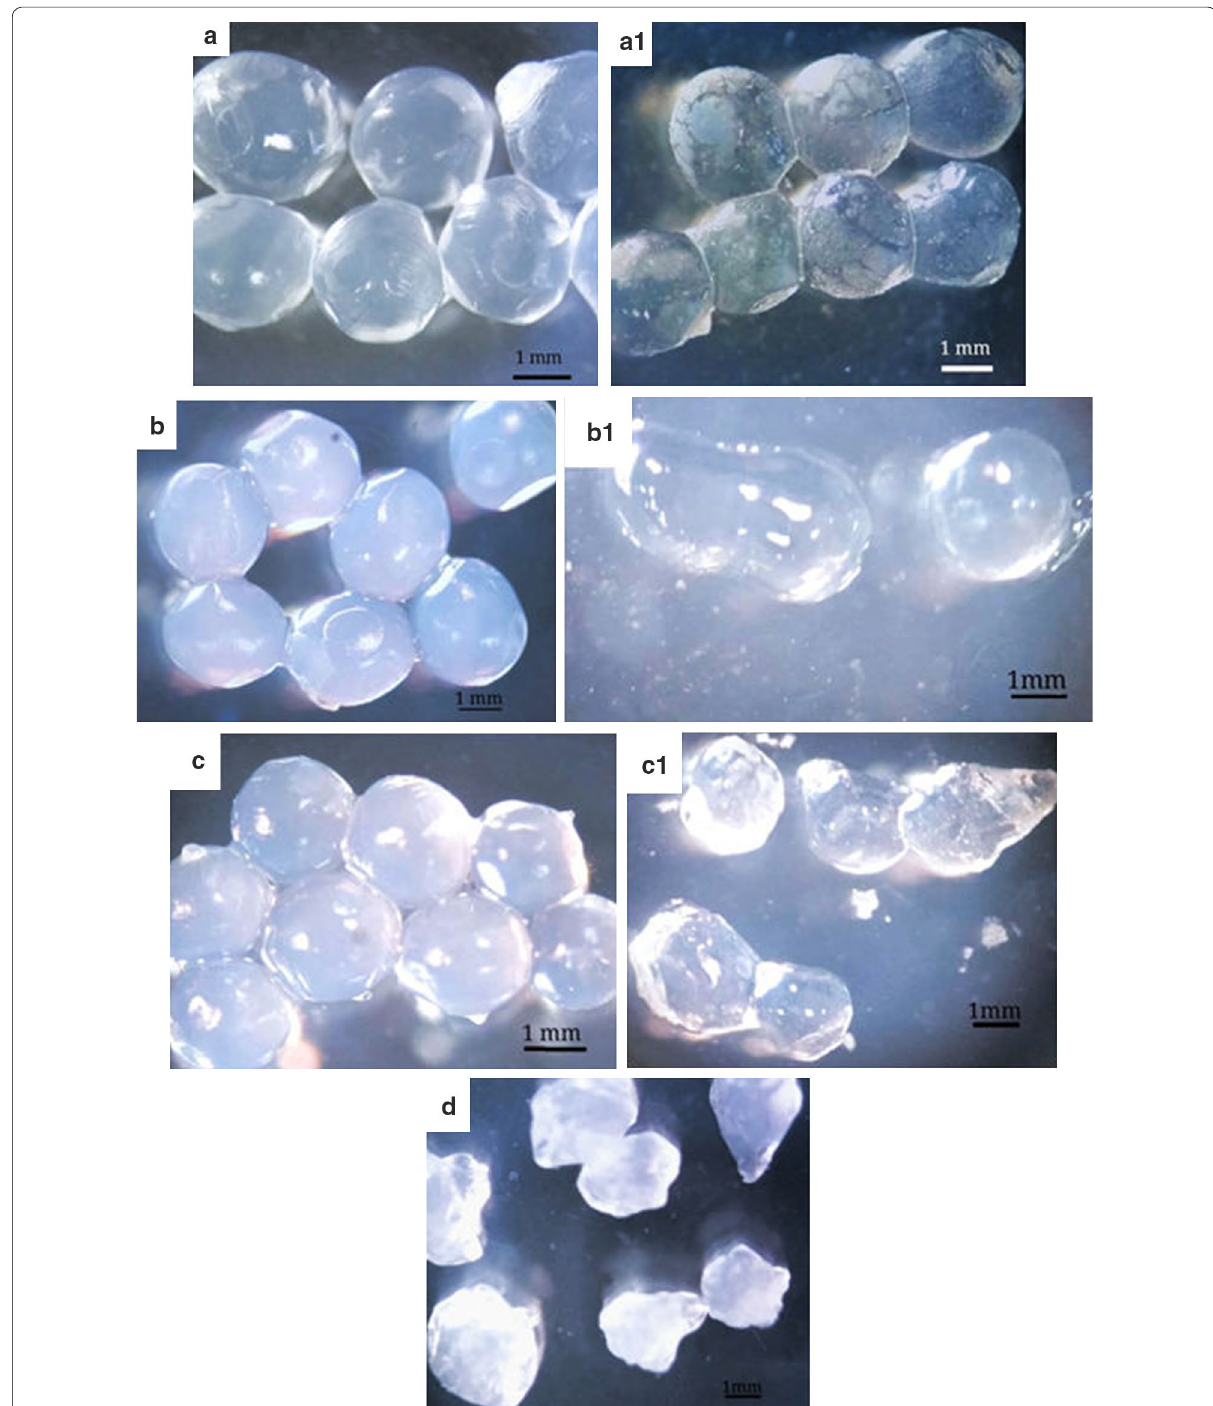
Fig. 2 Optical micrographs of beads 1 (0.3% honey, 0.25% gelatin) in fresh form ( a ), beads 1 after 1‑h incubation ( a1 ), beads 2 (3% honey, 2.5% gelatin) in fresh form ( b ), beads 2 after 1‑h incubation ( b1 ), beads 3 (50 mM Tris‑HCl pH 7.4) in fresh form ( c ), beads 3 after 1‑h incubation ( c1 ) and beads 4 (0.01% gelatin, 0.05% honey, 0.15 M NaCl and 10 mM MgSO 4 7H 2 O) in fresh form ( d ), each bead was loaded with bacteriophage ZCEC5 in · simulated intestinal